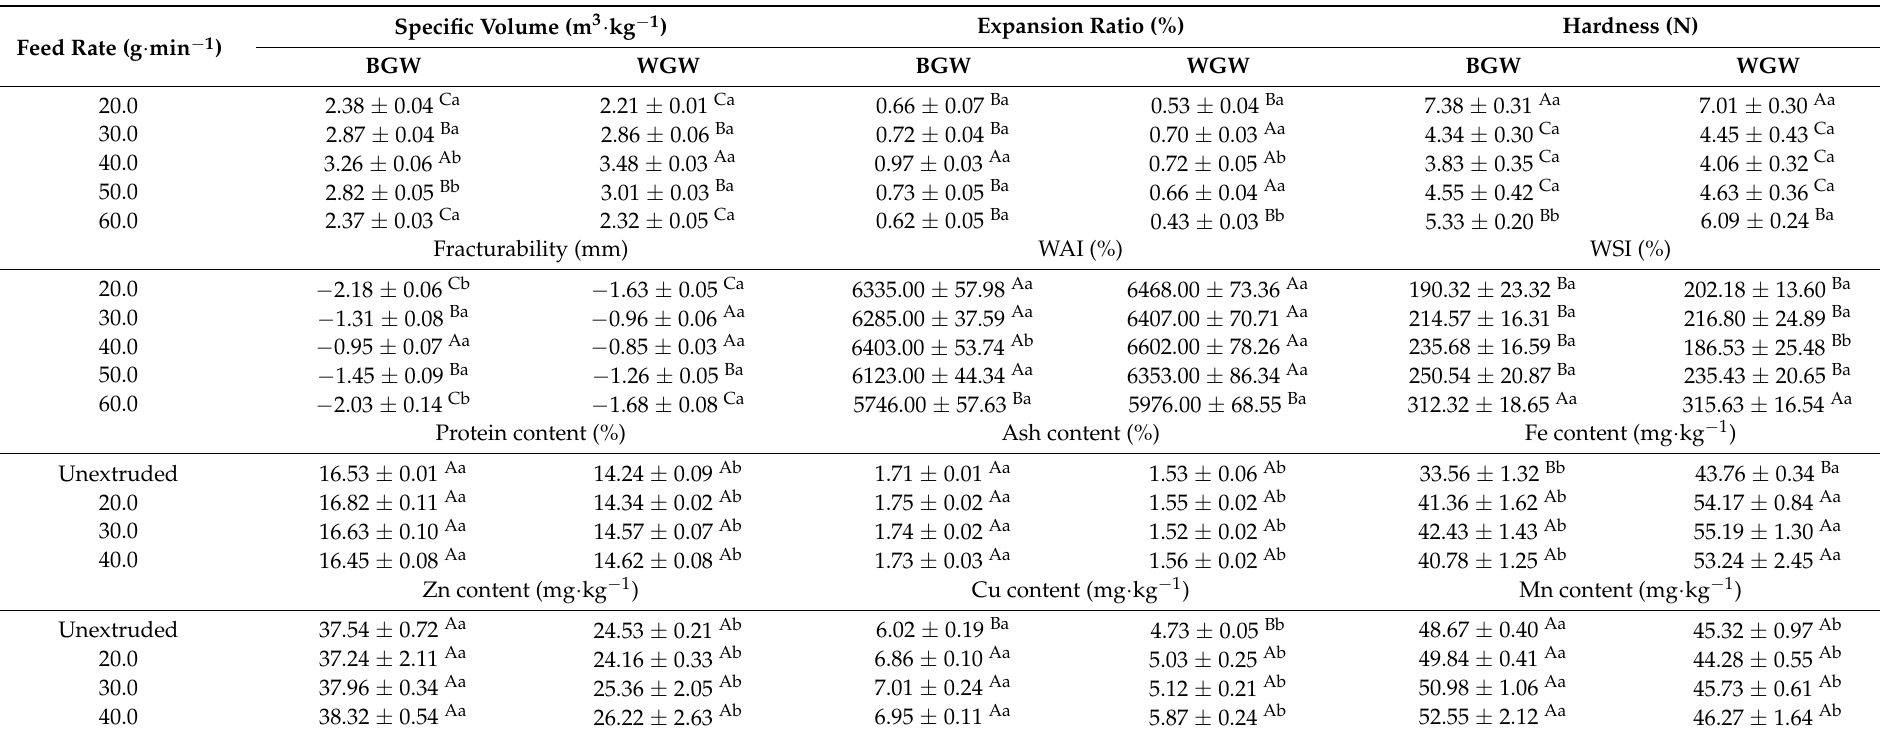
Table 7. Effect of the feed rate on the physical properties and nutritional components of the wheat